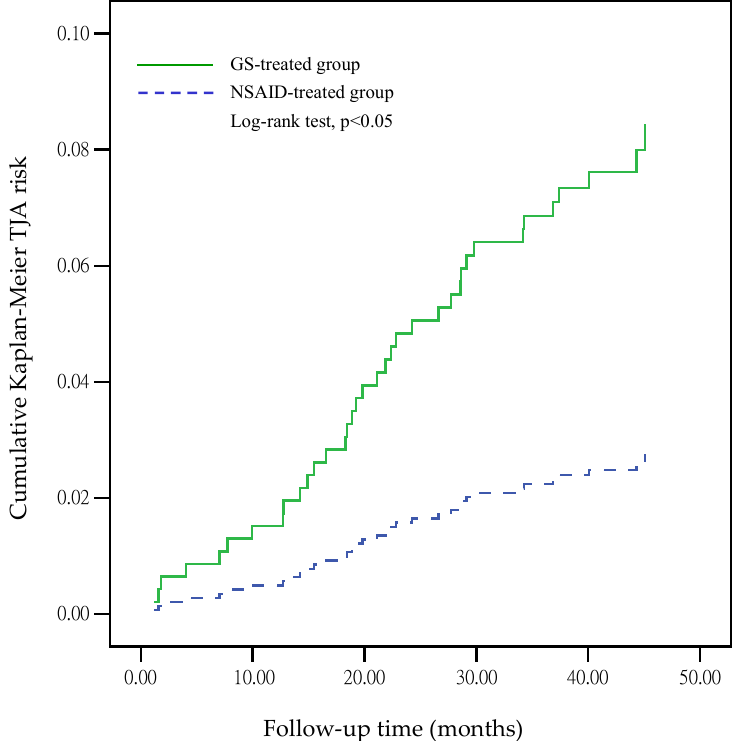
Figure 1. Kaplan–Meier estimates of cumulative TJA risks according to the GS-treated and the NSAID-treated groups.